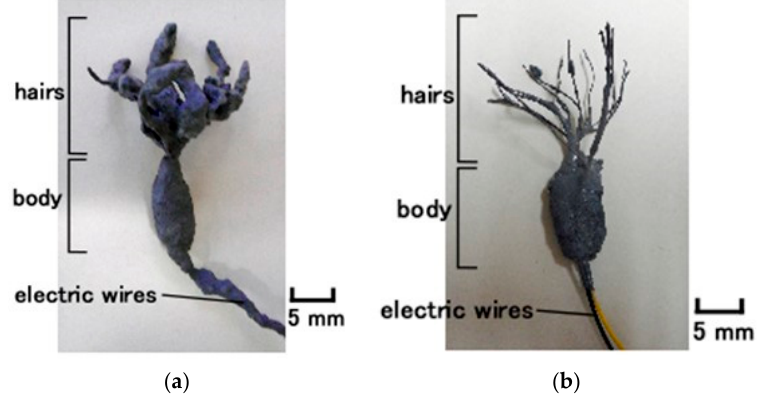
Figure 2. Images of the designed gustatory receptors produced using electrolytic polymerization with HF rubber: ( a ) cylindrical Pacinian corpuscles; and ( b ) layered Pacinian corpuscles. Actual human receptors have several types of mechanical or thermal receptors: nerve endings, Meissner corpuscles, Krause end bulbs, Pacinian corpuscles, Merkel cells, and Ruffini endings. Each receptor responds to a particular sensation—haptic, thermal, vibrat- ing, gustatory, or olfactory. In the present study we adopt the Pacinian corpuscles from a similarly structured configuration by comparison with the actual human gustatory recep- tor.